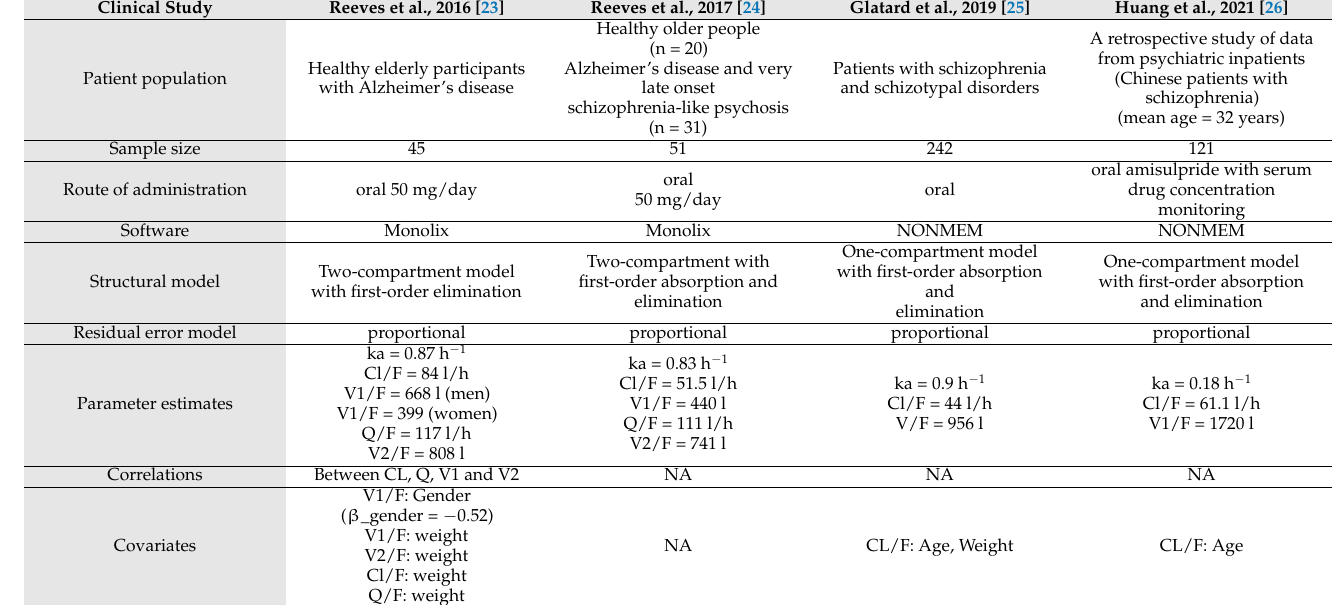
Table 3. Population models for amisulpride reported in the